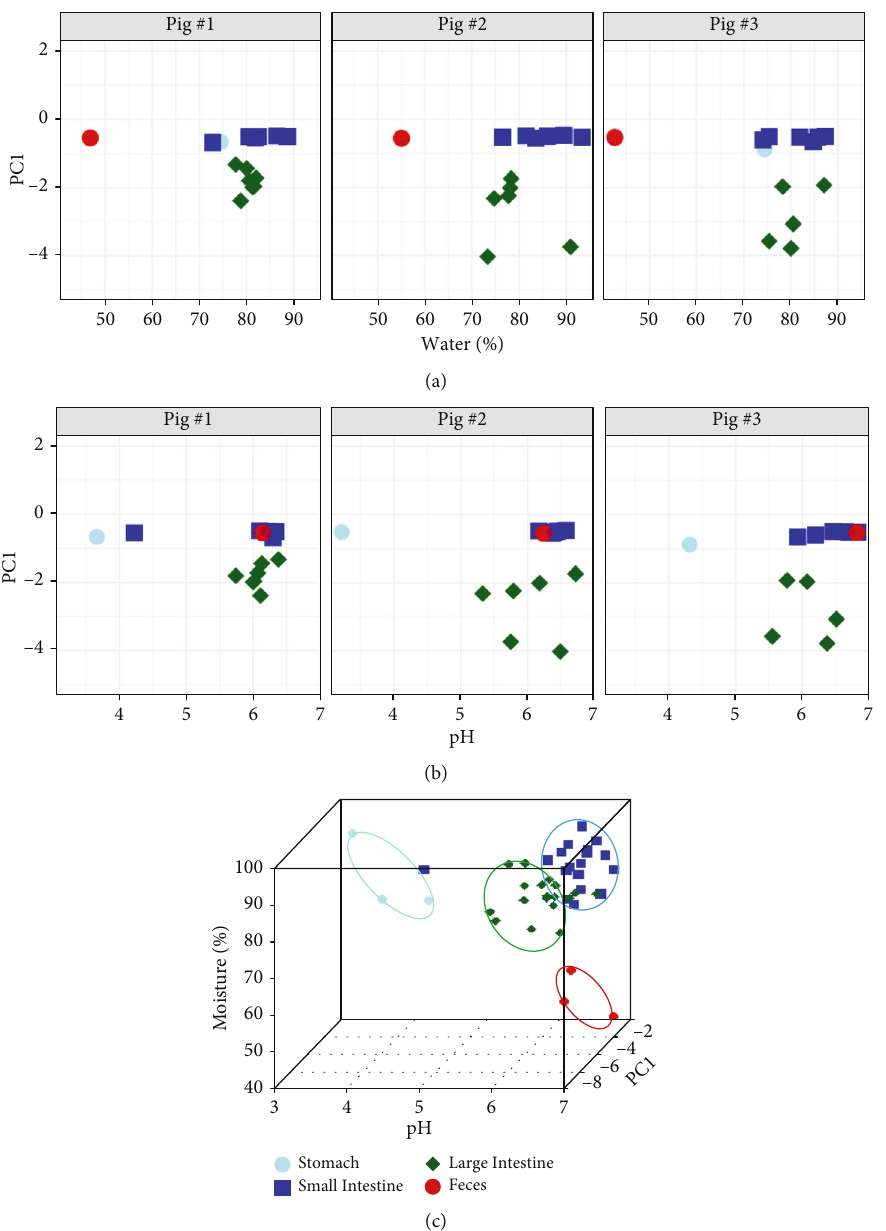
Figure 7: The associative relationship between gut microbiome structure and physical factors. (a) Water content versus the PC1 of gut microbiome. (b) pH versus the PC1 of gut microbiome. (c) 3D plot showing a relationship of water content, pH, and the PC1 of gut